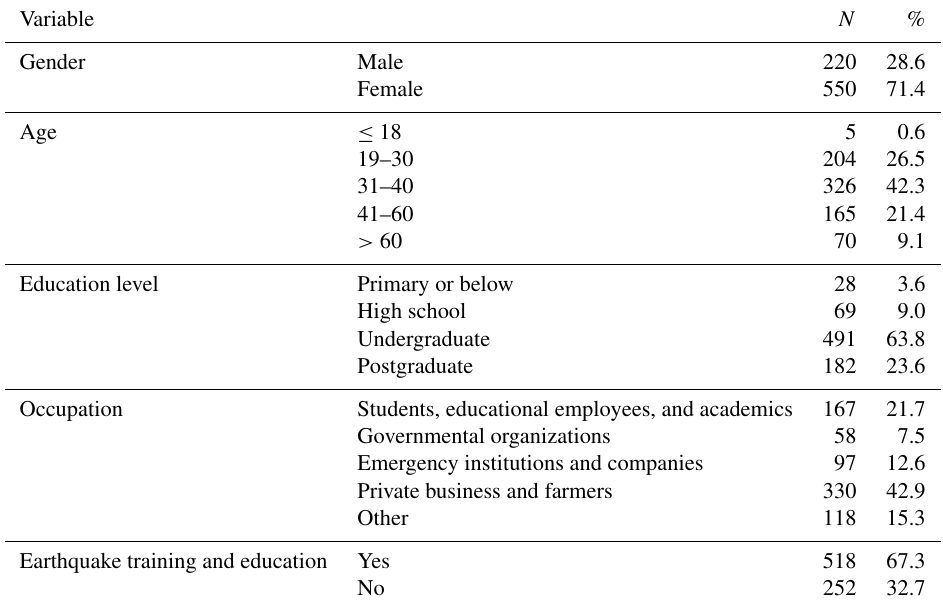
Table 1. Demographic profile of internet-based survey participants regarding responses to the early warning of the Changning earthquake ( N =